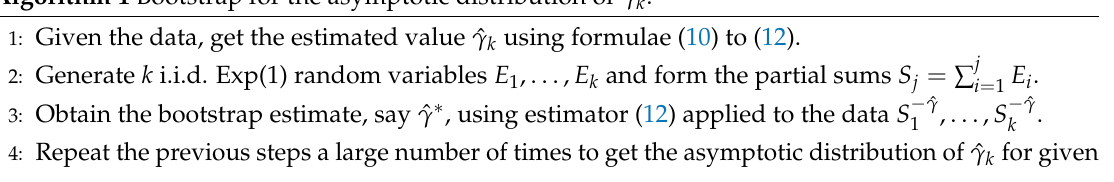
Algorithm 1 Bootstrap for the asymptotic distribution of ˆ γ k .